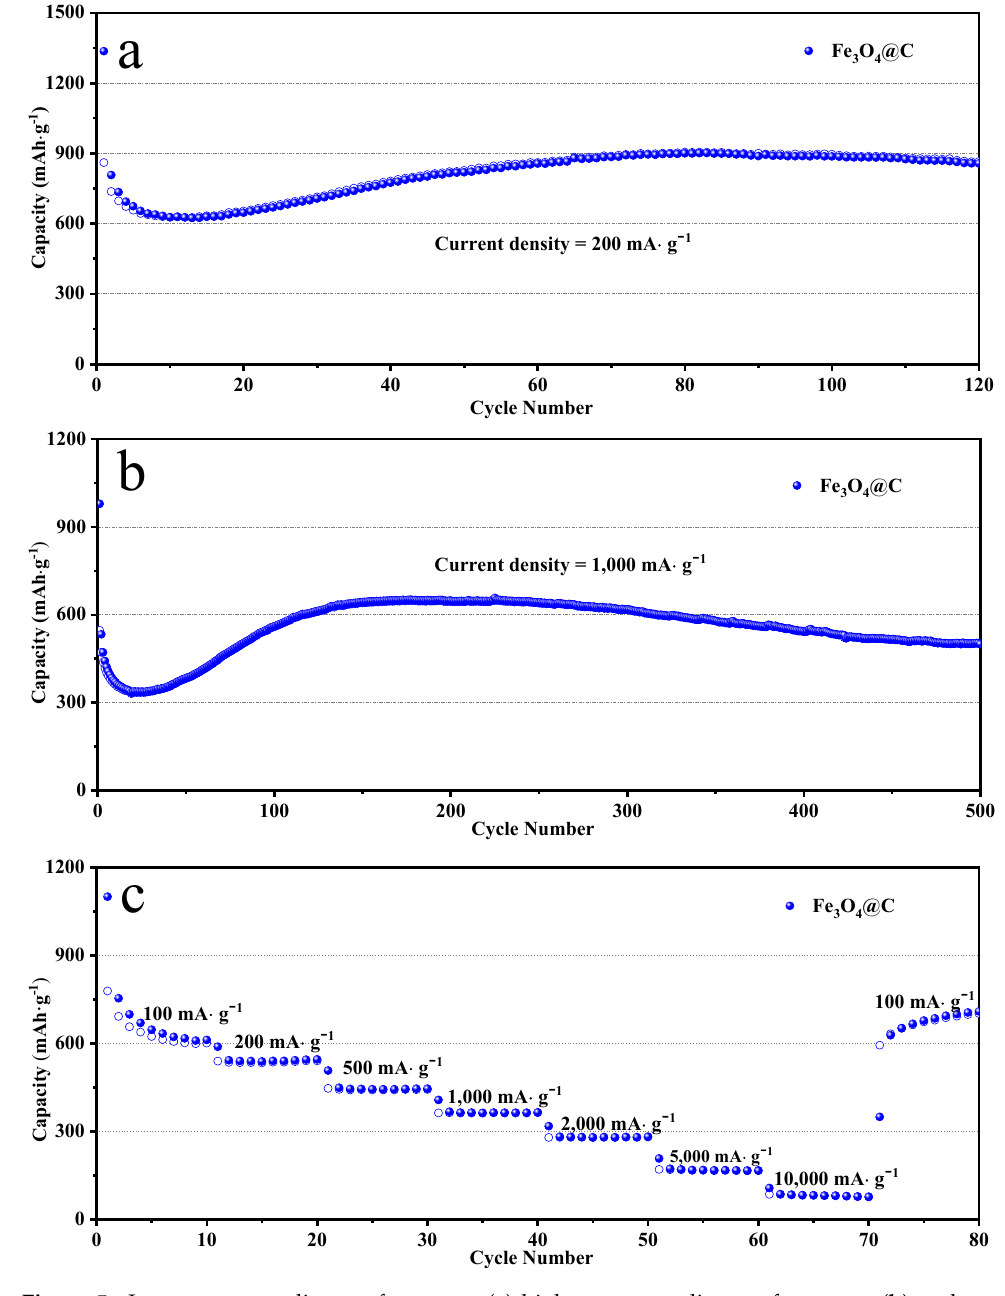
Figure 5. Low-current cycling performance, ( a ) high-current cycling performance, ( b ) and rate capability ( c ) of the Fe 3 O 4 @C sample.